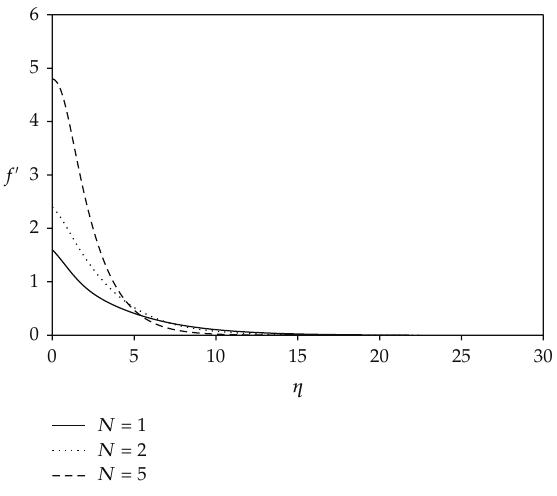
Figure 7: Velocity profile for di ff erent values of N for Du (cid:8) 0 . 03, Sr (cid:8) 2, θ r (cid:8) 5, Le (cid:8) 0 . 1, Pr (cid:8) 0 . 71, and Sc (cid:8) 0 .